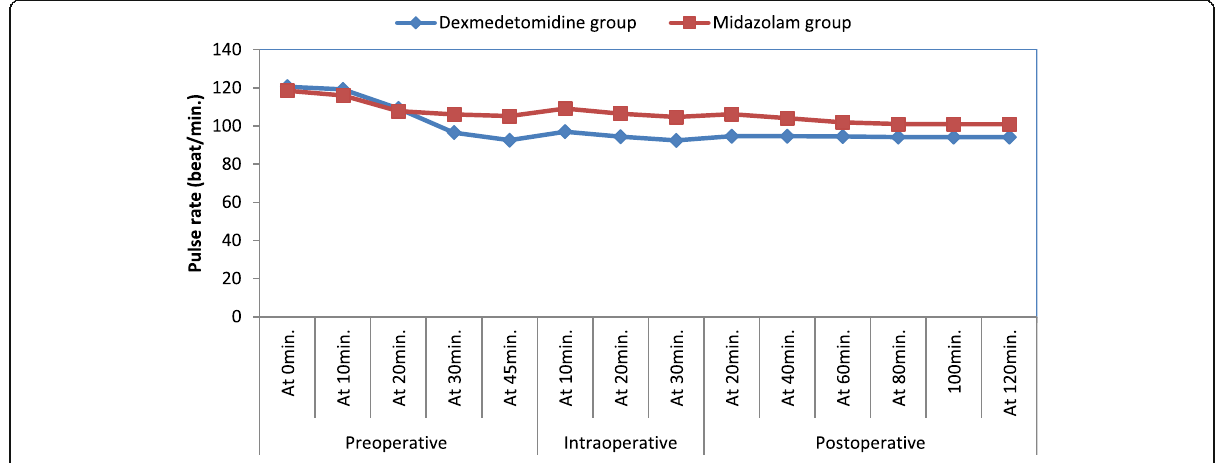
Fig. 1 Comparison between group D and group M regarding HR. Data are presented as mean (±SD)